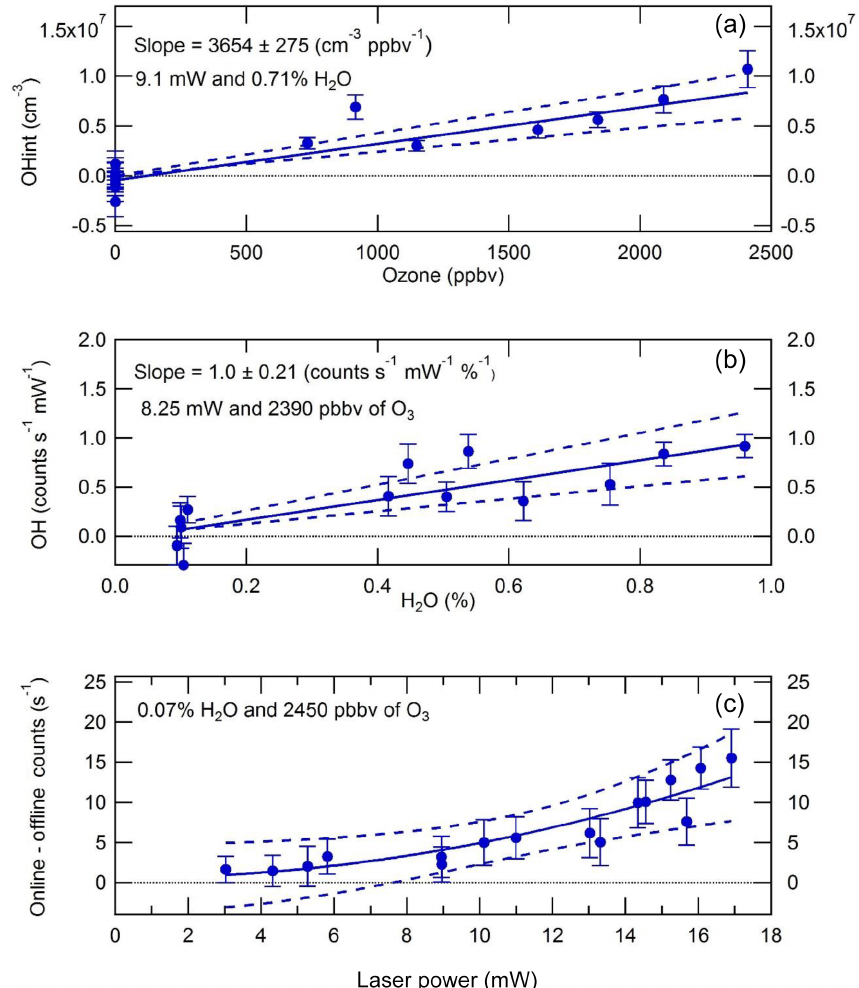
Figure 7. OH interference ( ± 1 σ ) from O 3 + H 2 O as a function of (a) O 3 , (b) H 2 O, and (c) laser power. The interference signal is linear in O 3 and H 2 O mixing ratios and quadratic in laser power, confirming the two-photon nature of the process. Normalising the slope in panel (a) to O 3 = 1ppbv, H 2 O = 1%, and laser power = 1mW yields an OH interference equivalent to a concentration of 565 ± 42molec.cm − 3